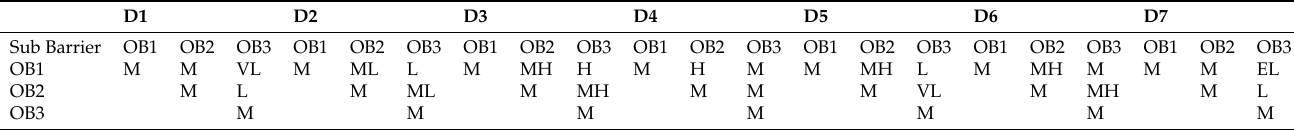
Table A7. The DMs judgments for the intra-organizational sub-barriers using linguistic variables.